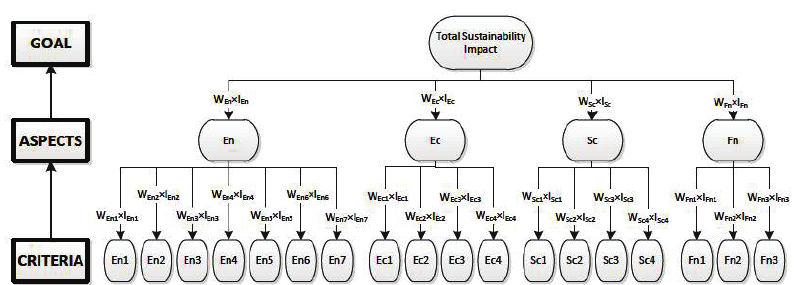
Figure 1. AHP hierarchical decision-making